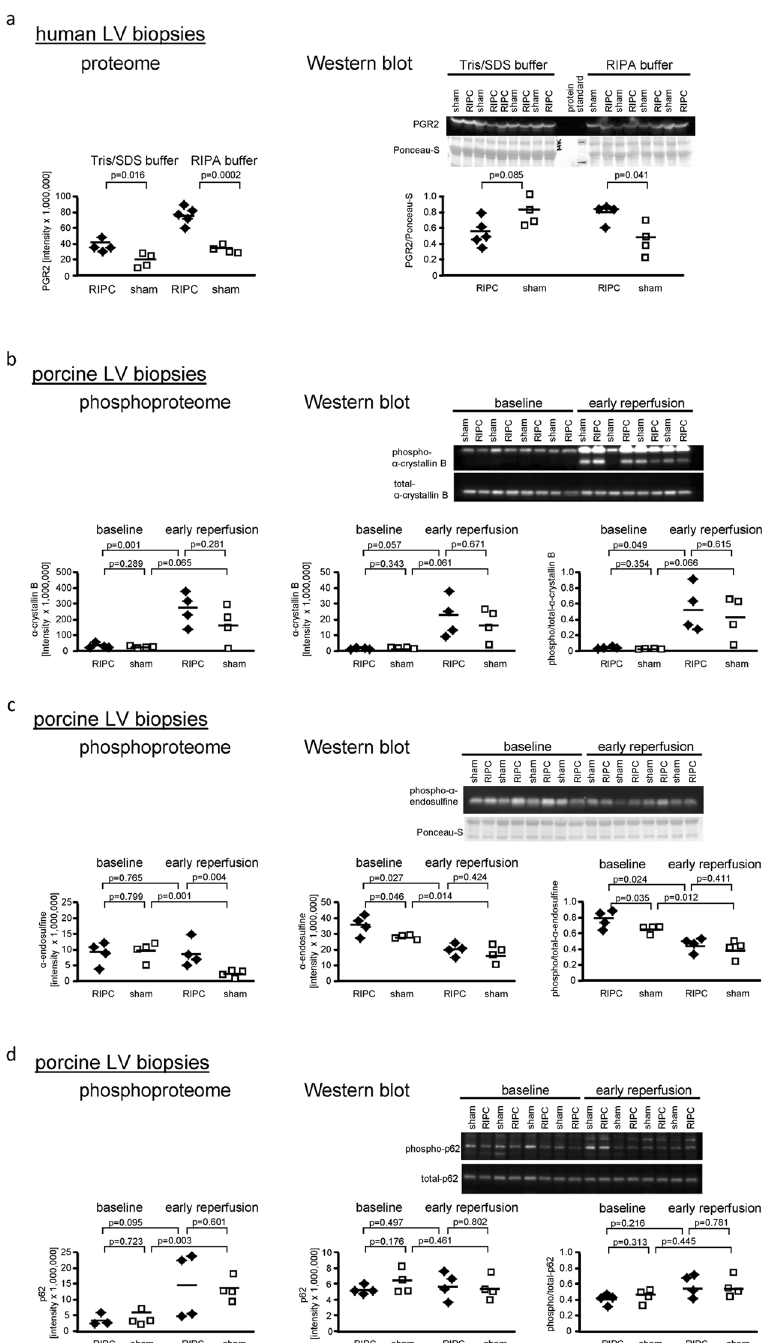
Figure 7. Comparison between proteome/phosphoproteome and Western blot analysis of prostaglandin reductase 2, α -crystallin B, α -endosulfine and p62 expression/phosphorylation. ( a ) The expression of prostaglandin reductase 2 (PGR2) in Tris/sodium dodecyl sulfate (Tris/SDS) and in radioimmunoprecipitation assay (RIPA) buffer lysed human left ventricular (LV) biopsies with remote ischemic preconditioning (RIPC; black symbols) and with sham (white symbols) in the proteome and in the Western blot analysis. The higher expression of PGR2 with RIPC than with sham in RIPA buffer-lysed human LV biopsies was confirmed by Western blot analysis. The immunoreactivity of PGR2 was normalized to Ponceau-S staining. The phosphorylation of ( b ) α -crystallin B at ser 59 , ( c ) α -endosulfine at ser 67 and ( d ) p62 at thr 269 /ser 272 in the phosphoproteome and in the Western blot analysis with RIPC and with sham in porcine left ventricular biopsies taken at baseline and at early reperfusion. The phosphoproteome analysis was verified by Western blot analysis for α -crystallin B and p62, but not for α -endosulfine. The immunoreactivities of the phosphorylated proteins were normalized to the respective total forms and compared by unpaired (between RIPC and sham) or by paired (between baseline and early reperfusion) Student’s t-tests. Total α -endosulfine was not detectable, therefore phosphorylated α -endosulfine was normalized to Ponceau-S staining. The blots were cropped to display the relevant bands, full-length blots and Ponceau-S stainings are presented in Supplemental Figs S6 and